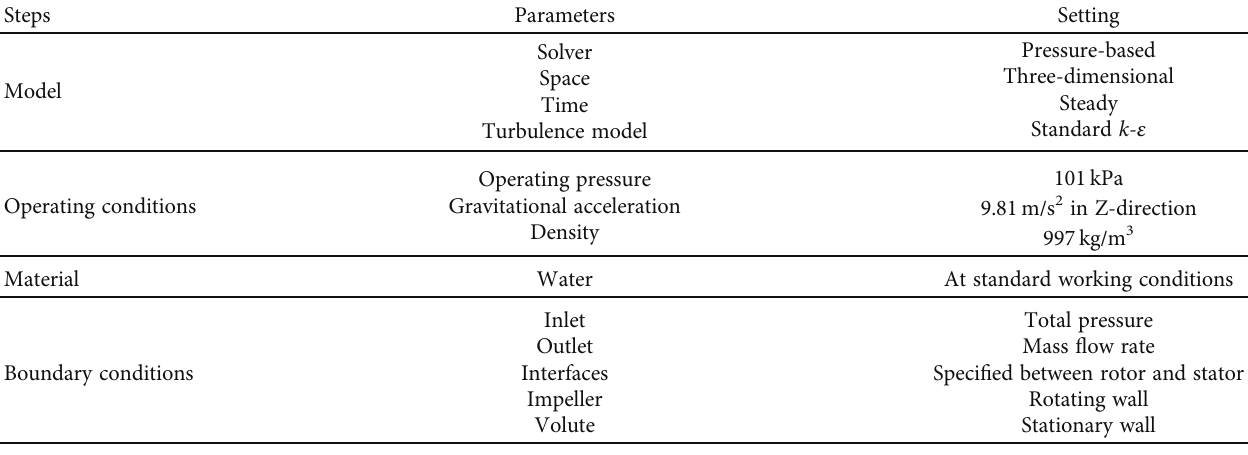
Table 2: Basic assumptions and settings used in the CFD analysis.